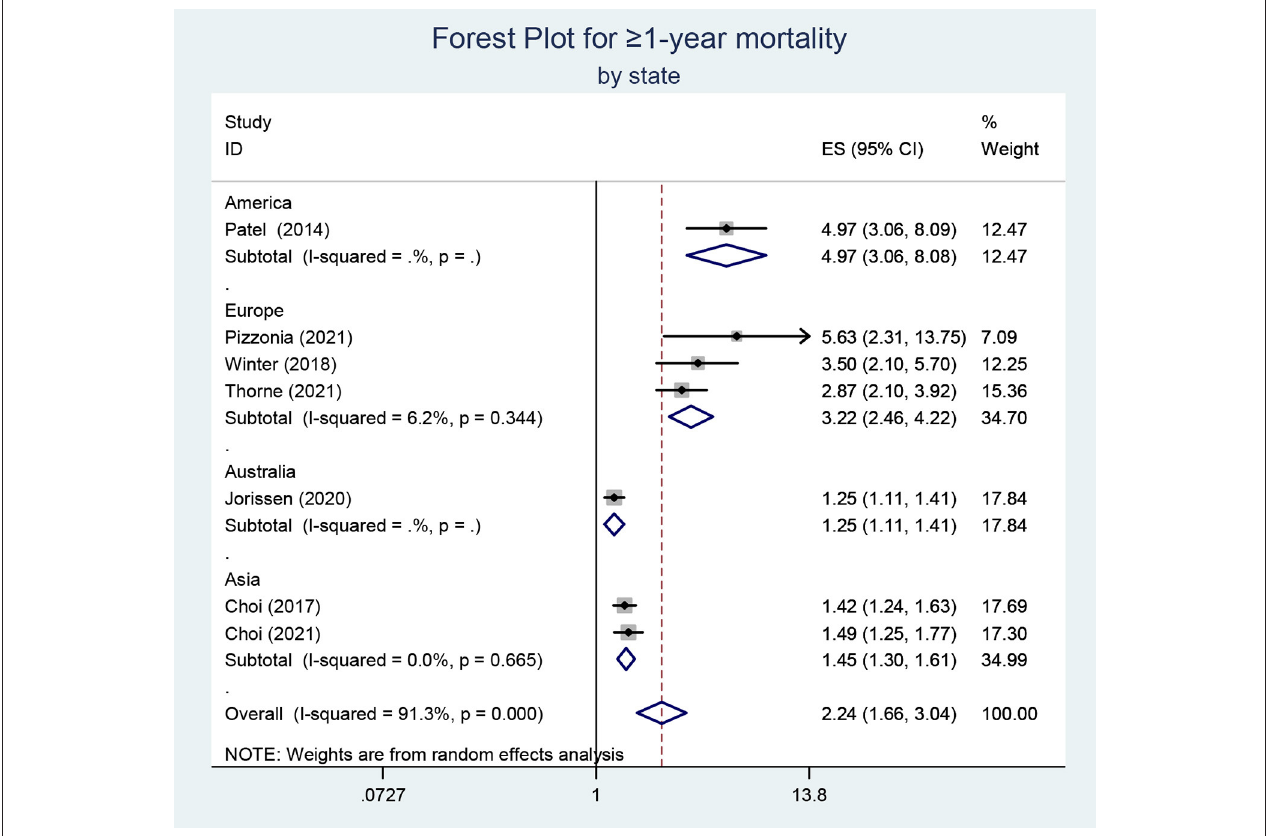
FIGURE 2 | Subgroup analysis for the studies reporting ≥ 1-year